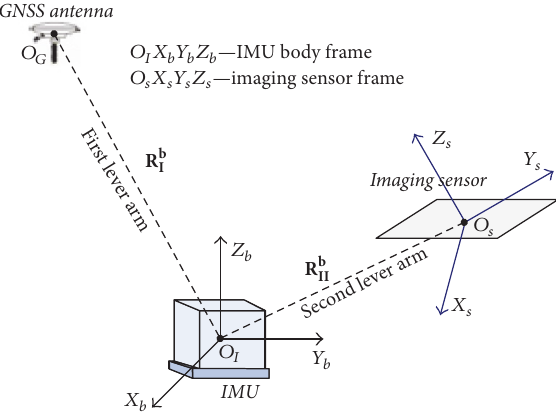
Figure 2: Multilevel rigid lever arm mechanism.